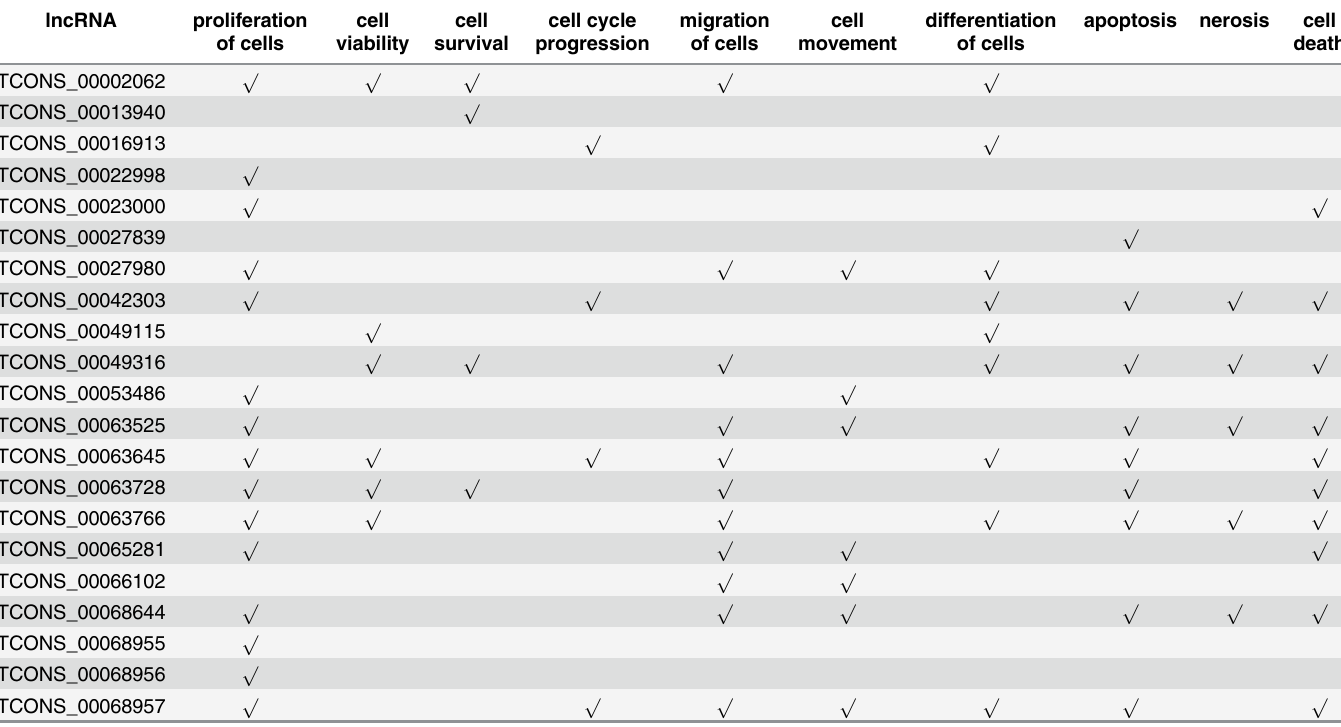
Table 3. The physiological activities that regulated by